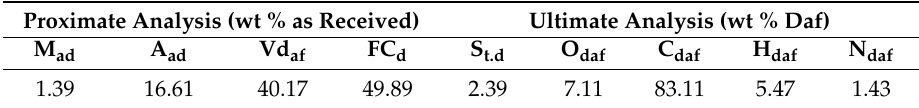
Table 5. The proximate and ultimate analysis of XF coal samples.